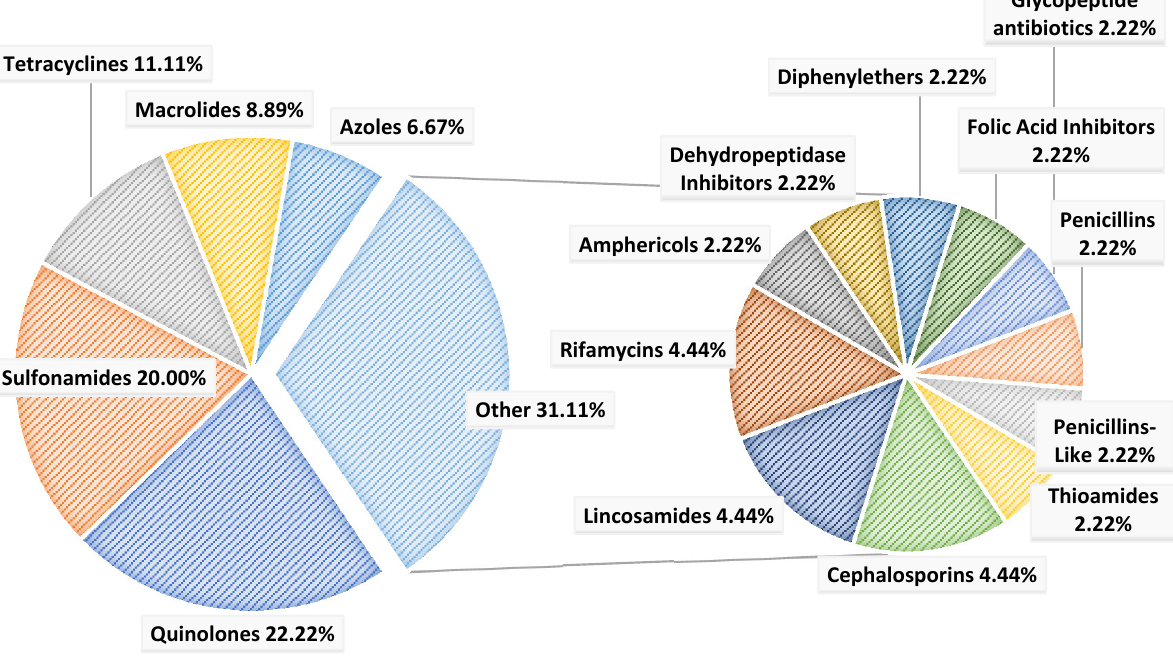
(Figure 4). Seven of those, namely ciprofloxacin, clarithromycin, erythromycin, metronida- zole, ofloxacin, sulfamethoxazole and trimethoprim, occurred in more than 50% of studies (nine). In particular, ciprofloxacin, sulfamethoxazole and trimethoprim were detected in more than 75% of papers (fourteen). Azithromycin, clindamycin, norfloxacin, oxytetracy- cline, roxithromycin, sulfadiazine and tetracycline occurred within five and nine studies (25–50%).